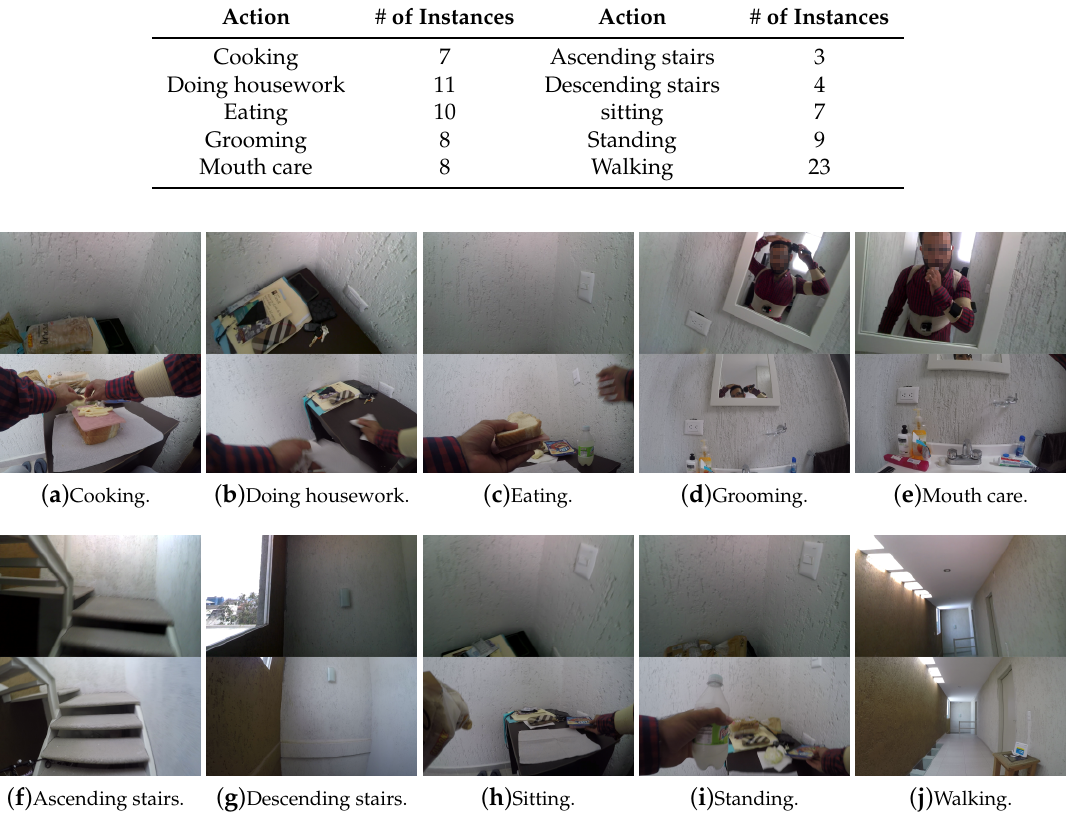
Figure 2. Actions performed by a subject in his daily living environment while his movements were captured by the wearable inertial sensors and the cameras recorded video. The top image of each Subfigure was captured by the Google Glass, and the bottom image was captured by the GoPro Hero 4 carried on the